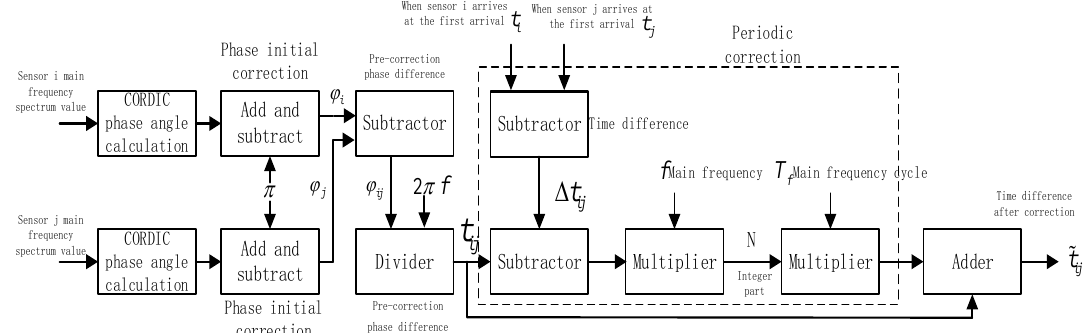
Figure 17. Block diagram of the phase-difference measurement and calibration circuit design.